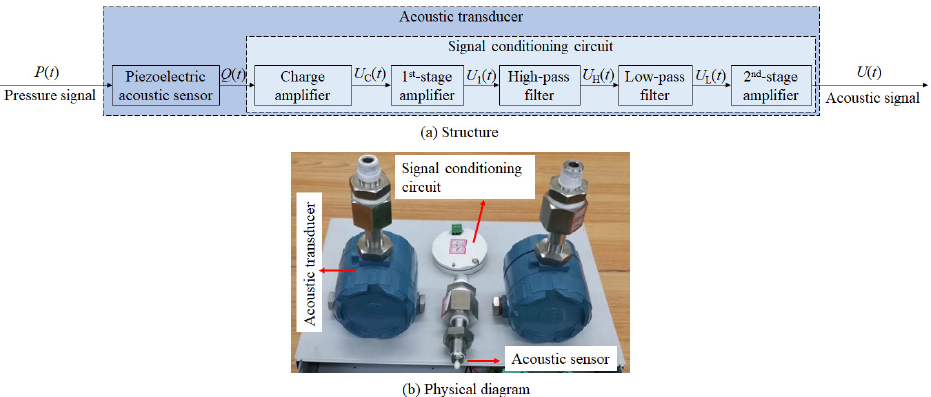
Figure 2. Acoustic transducer: ( a ) structure, ( b ) physical diagram.